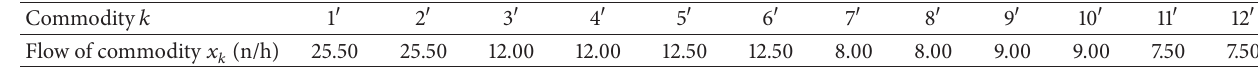
Table 7: Optimal solutions on the lowerlevel.